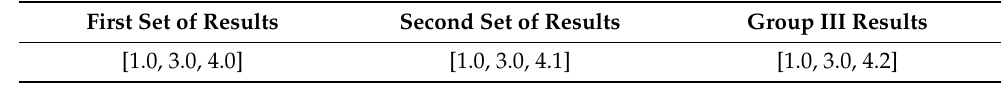
Table 1. The graph showing the measured results of the algorithm.